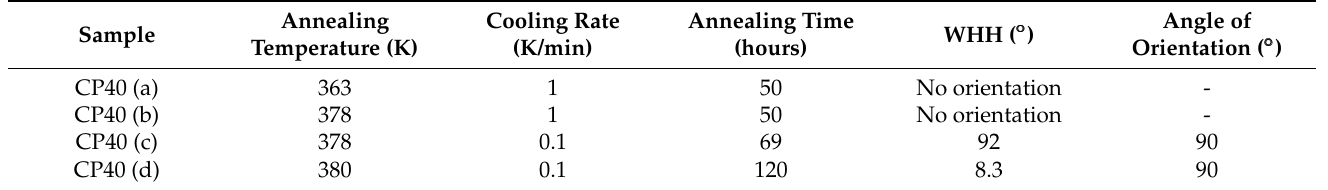
Table 3. Different thermal treatments and resulting peak width at half height (WHH) and angle of orientation of annealed membranes of the CP40